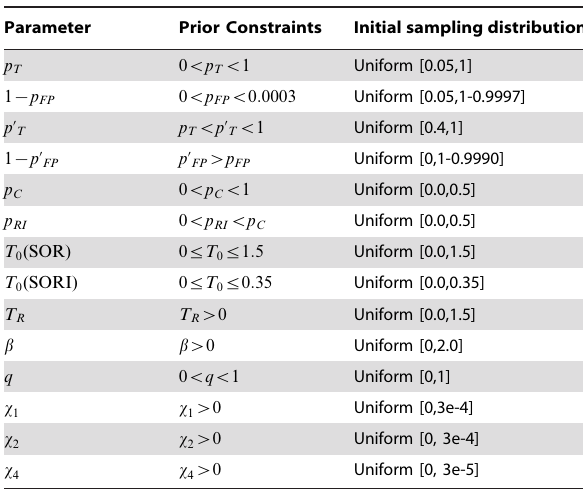
Table 2. Prior assumptions.